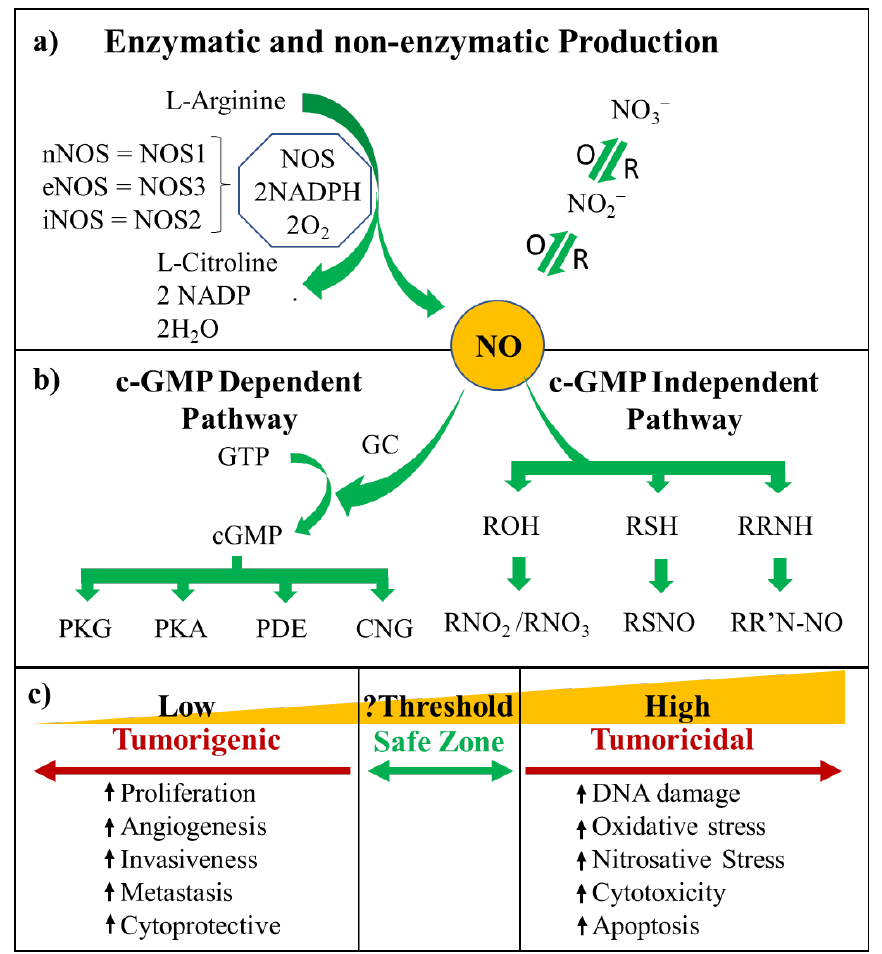
Figure 1. NO formation, its mechanism of action, and its phenotypic consequences: ( a ) Enzymatic and non-enzymatic synthesis of NO and facilitation of nitrogen oxide interchange. ( b ) Downstream signalling events induced by NO. The cGMP-dependant pathway shows the interaction of NO with soluble guanylate cyclase (sGC) which catalyses the conversion of GTP to cGMP. cGMP then triggers protein kinase G (PKG), protein kinase A (PKA), phosphodiesterases (PDE), and ion gated channels (CNG). The cGMP-independent pathway involves the posttranslational modification of proteins containing, thiols (RSH), and amines (RR’NH), which react with RNS formed from NO to produce nitrite/nitrate (RO-NO), S-nitrosothiols (RSNO), and N-nitrosoamines (RR’NNO), respectively. ( c ) Concentration-dependent effects of NO in cancer. Low levels produce pro-tumourigenic effects while high NO is predominantly anti-tumour. Created with BioRender.com.